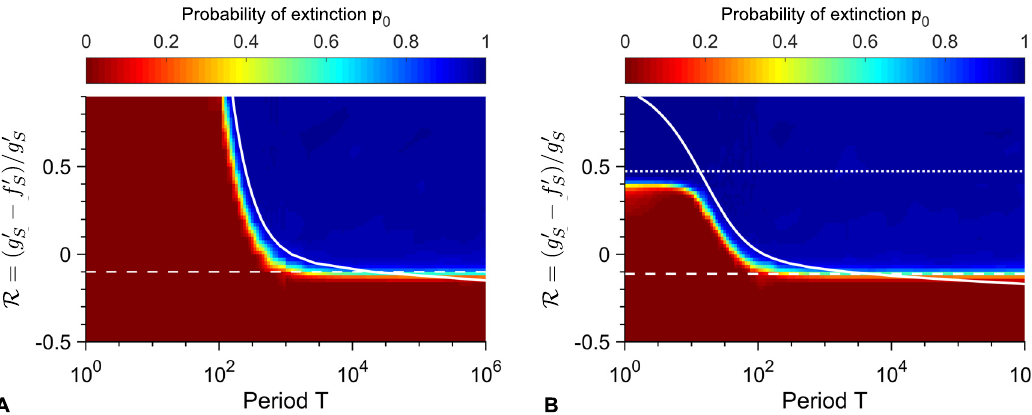
Fig 5. Heatmaps of the extinction probability. Extinction probability p 0 versus alternation period T and R ¼ ð g 0 biostatic ( A ) or biocidal ( B ) antimicrobial. Heatmap: simulation data, each point computed over 10 3 realizations of simulation results, and linearly interpolated. Dashed white line: value of R such that t a Parameter values: K = 10 3 , μ 1 = 10 − 5 , μ 2 = 10 − 3 , f S = 1, f R = 0.9, f C = 1, g S = g R = g C = 0.1, and ( A ) g 0 and variable g 0 . Dotted line in B : R ¼ ð f S